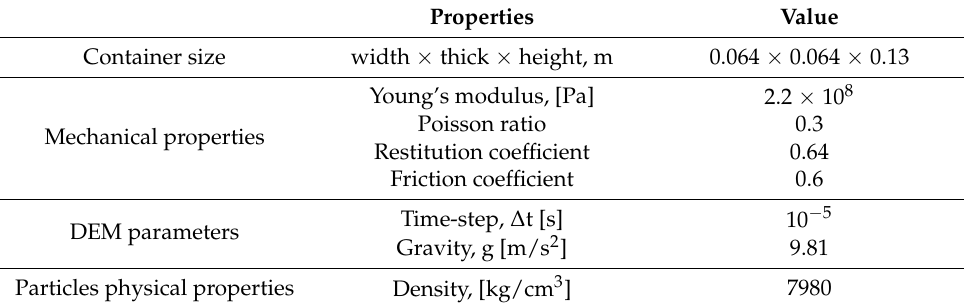
Table 2. Mechanical properties of stainless-steel particles and parameters of DEM simulations [37].